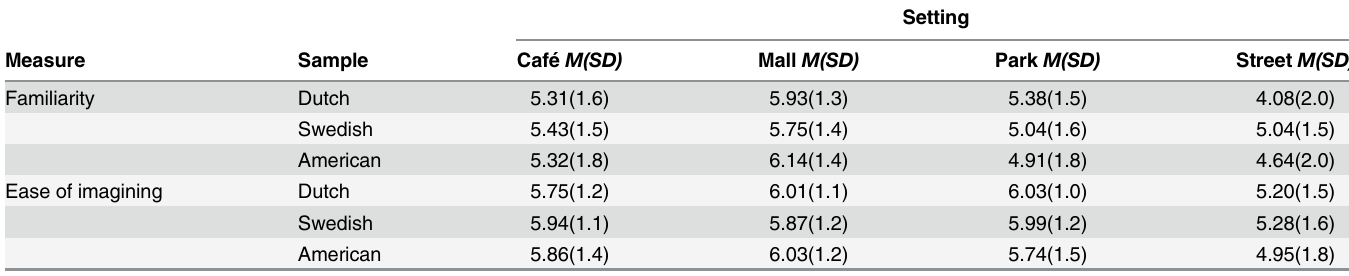
Table 3. Descriptive statistics (means and standard deviations) for the checks on the familiarity and ease of imagining being in each activity-in- environment (setting) broken out by sample country.